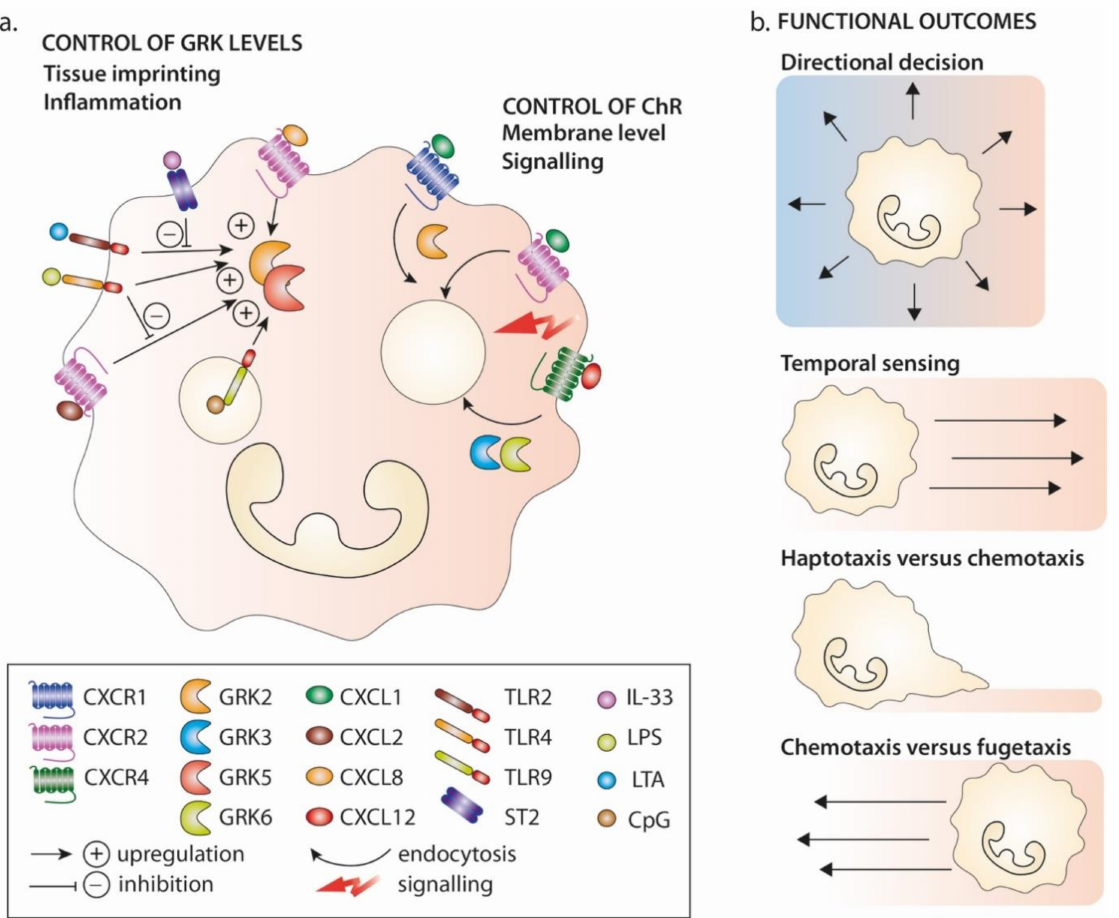
Figure 3. GRK regulation and function in neutrophils. ( a ) Neutrophils are among the immune cells that express GRK2, 3, 5 and 6 at the highest levels. GRK may participate in the tissue-driven imprinting of neutrophils by notably modulating chemokine receptors expression level and signalling. Several exogenous ((LPS via TLR4) [5,158], CpG oligodeoxynucleotide (via TLR9) [159], (LTA via TLR2) [157]) and endogenous (CXCL2 [162] or CXCL8 and LTB4 in the presence of inflammatory chemokines [156]) inflammatory signals upregulate GRK2 and/or GRK5 protein expression levels (depicted by the “+” symbol). LPS [162] and interleukin (IL)-33 (through ST2 receptor engagement) [160] can limit this increase (depicted by the “ − ” symbol). The cell colour gradient represents the integration of GRK relative levels and activities into chemokine receptor levels and function. ( b ) GRK-dependent regulation contributes to the migratory outcomes of neutrophils from directional migration to temporal sensing (e.g., haptotaxis or chemotaxis, as well as fugetaxis in some contexts). The colour gradients represent the chemokine concentrations, different colours meaning different